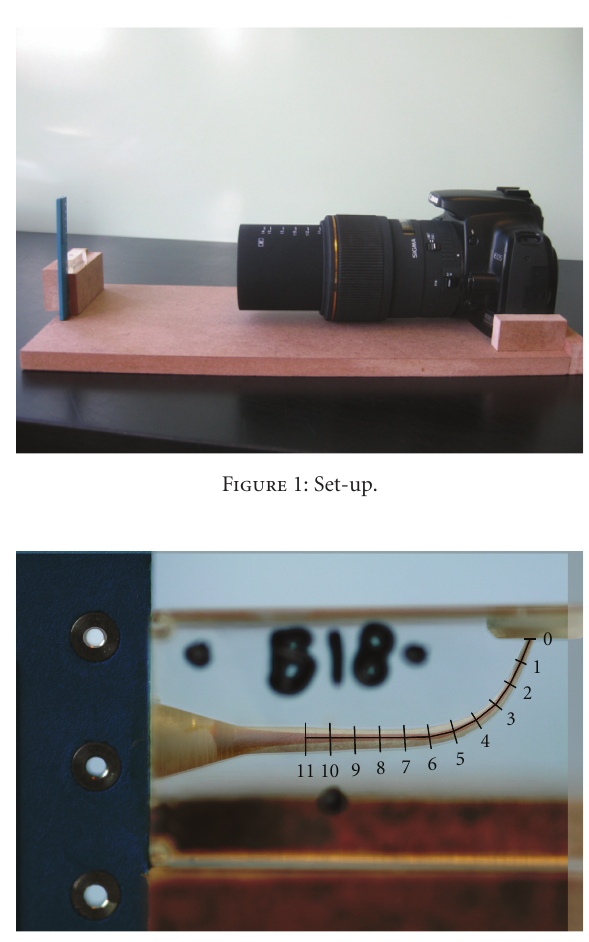
Figure 2: L-shaped simulated canals: pictures